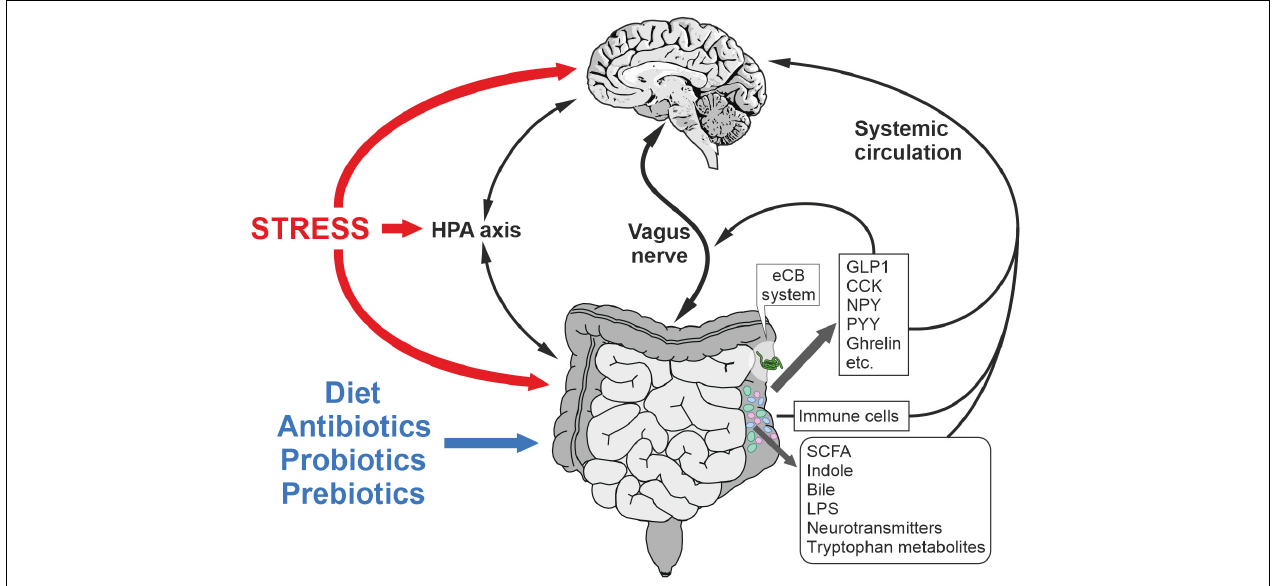
FIGURE 2 | Microbiota-gut-brain axis in the regulation of stress responses and metabolism. Mechanisms underlying the bidirectional communication include the vagus nerve, immune system, circulating mediators and HPA axis. Microbiota composition is affected by stress, diet, prebiotics, postbiotics and antibiotics among other factors. CCK, cholecystokinin; GLP-1, glucagon-like peptide-1; LPS, lipopolysaccharide; NPY, neuropeptide Y; PYY, polypeptide YY; SCFA, short chain fatty